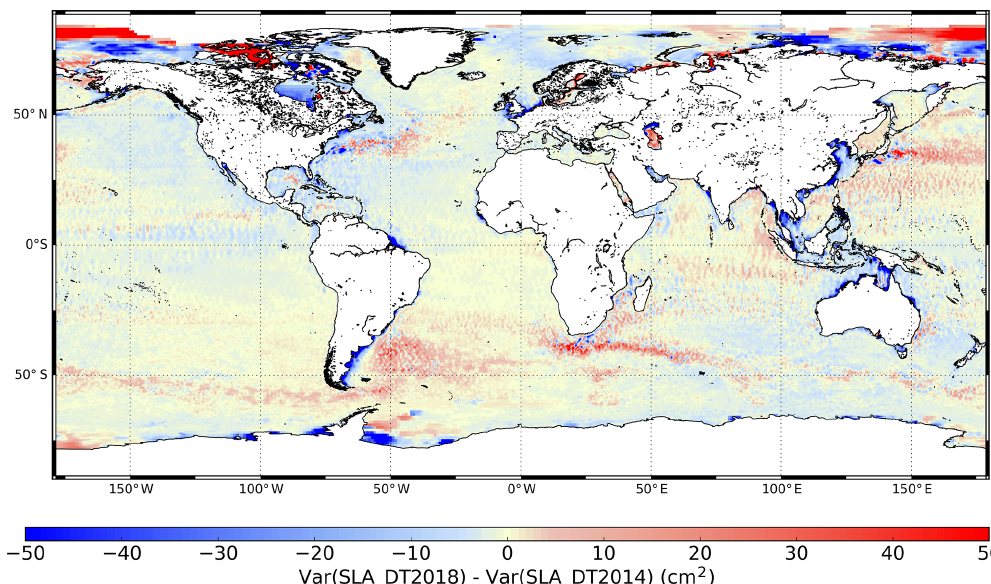
Figure 3. Difference between SLA variance observed with DT2018 gridded products and SLA variance observed with DT2014 gridded products over the 1993–2017 period.